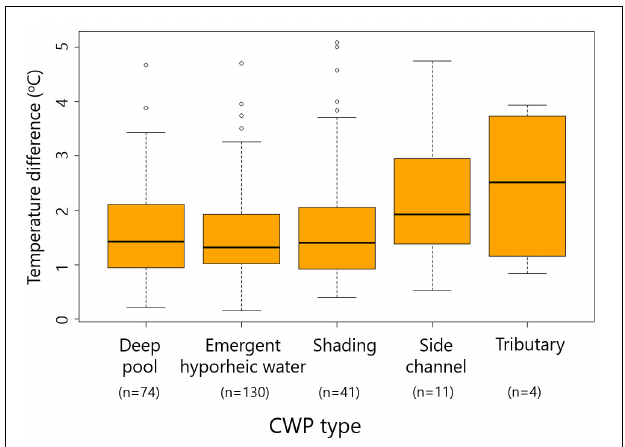
FIGURE 6 | Range of temperature differences promoted by each CWP type in relation to the main channel average temperature. Note that n refers to the number of data points for each CWP